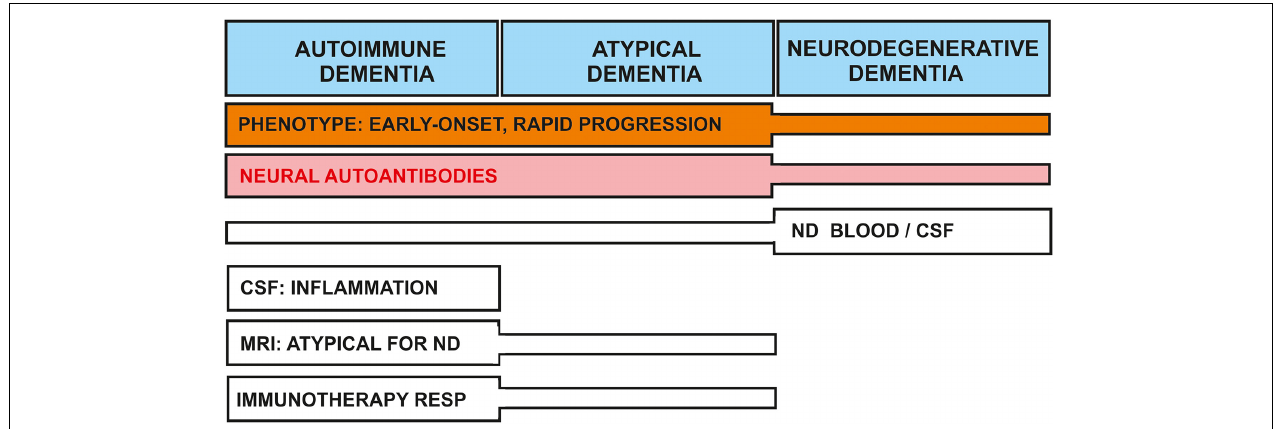
FIGURE 2 | Nosology of dementia associated with neural-autoantibodies: shared and separate features between dementia types. Clinical and laboratory features of dementia subtypes are delineated. The early onset, atypical clinical presentation, and/or rapid progression phenotype is often observed in conjunction with autoimmune and atypical dementias; they are less often encountered in neurodegenerative dementia. Neural autoantibodies may be present in all dementia types, but less frequent in neurodegenerative dementia. Neurodegenerative markers are often positive in neurodegenerative dementia, but are detected less often in autoimmune or atypical dementias. Other features such as CSF inflammation and a non-neurodegenerative pattern in MRI are characteristic for autoimmune and possibly atypical dementia. Patients with autoimmune dementia and occasionally atypical dementia may both be immunotherapy-responsive. ND, neurodegeneration; RESP,